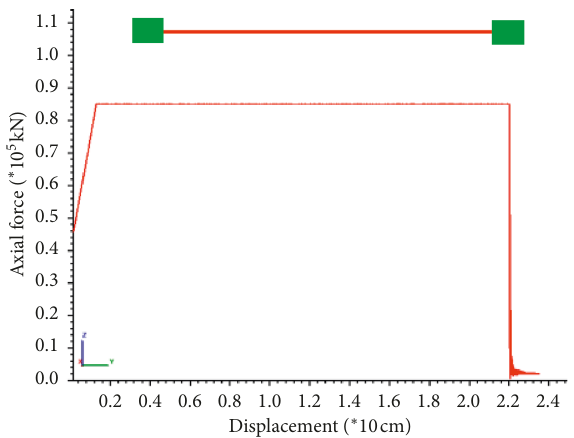
Figure 21: NPR anchor cable model and its static tensile properties.